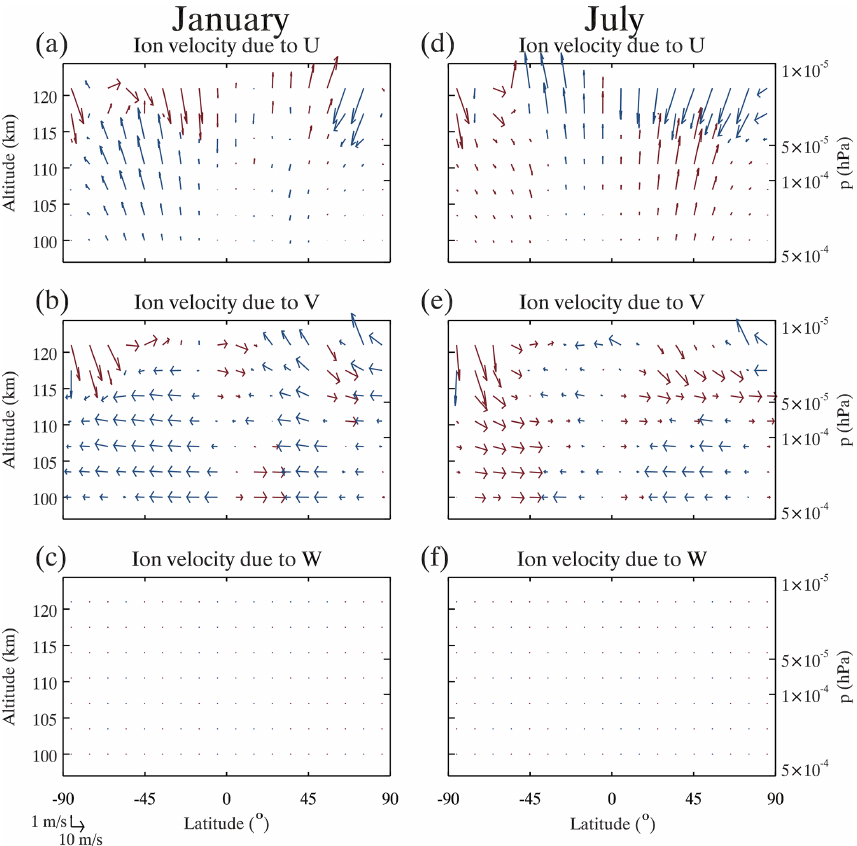
Figure 1. Ion velocity due to zonal ( U ), meridional ( V ), and vertical ( W ) wind in January (a–c) and July (d–f) . The red arrows denote the northward ion drifts, and the blue arrows denote the southward ion drifts (vertical and meridional vectors with scale 1m · s − 1 / 10m · s − 1 ).